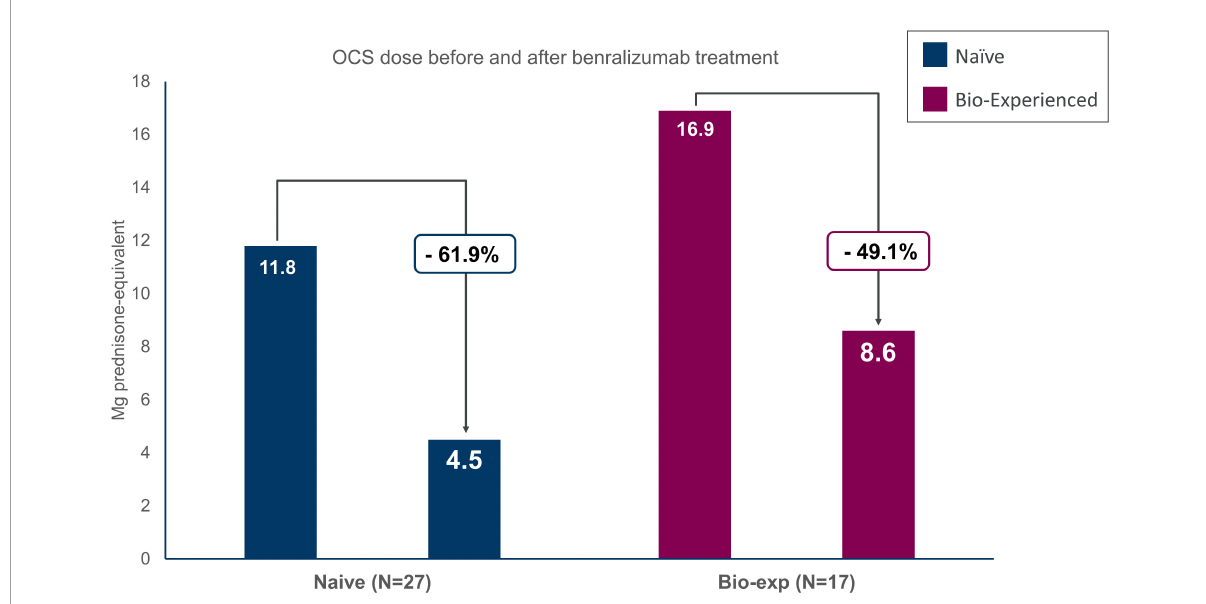
FIGURE4 Oral corticosteroids (OCS) sparing effect of benralizumab in severe eosinophilic asthma (SEA) patients with (biologic-experienced) and without (naïve) previous use of a biologic drug. Dose is reported in milligrams of prednisone